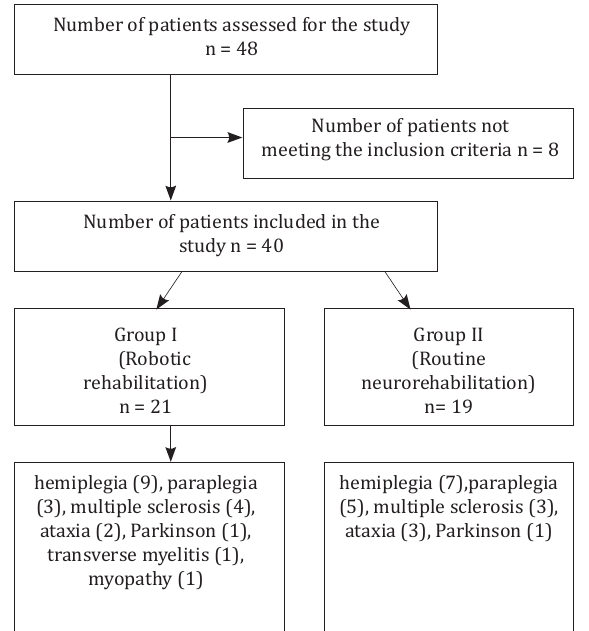
Figure 1 - Flow chart of the study